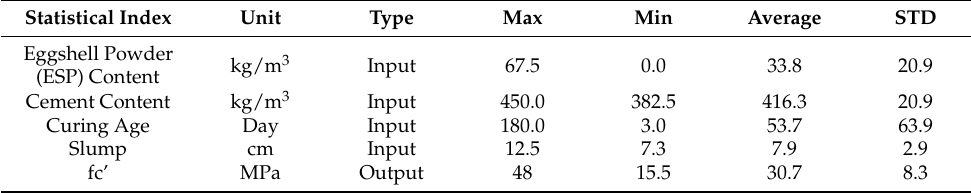
Table 5. Input and output variable properties.